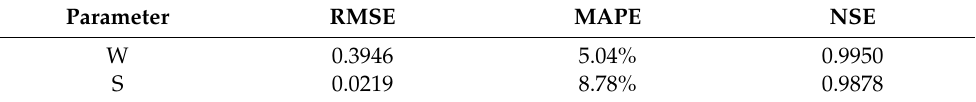
Table 3. Comparison of simulation results for evaluating the method performance.